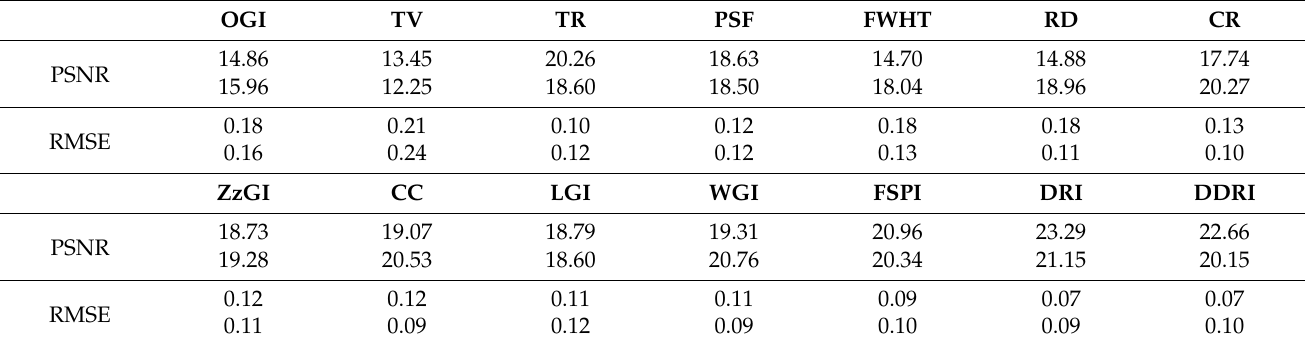
Table 3. PSNR and RMSE of images corresponding to Figure 3.